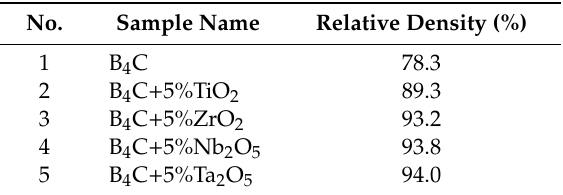
Table 2. The relative densities of the di ff erent